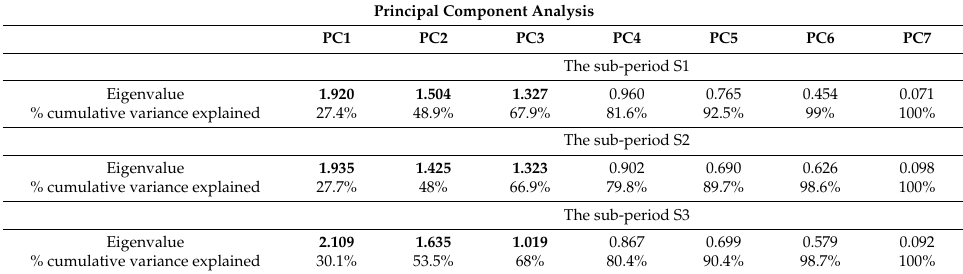
Table 5. The summarized PCA results from seven liquidity proxies for three sub-periods on the